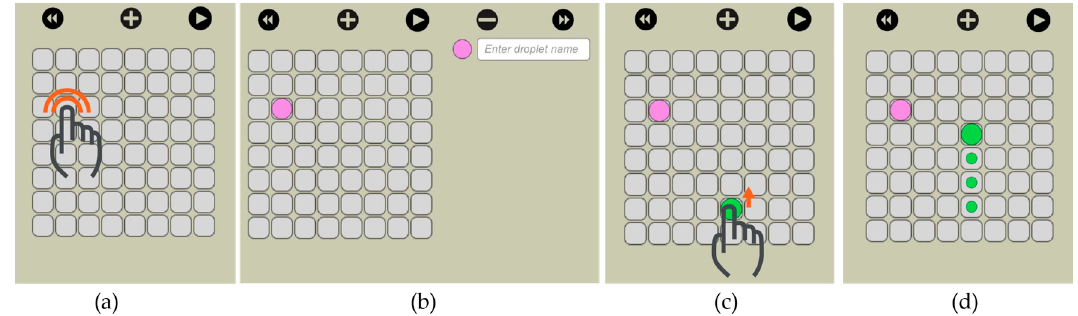
Figure 11. Through the software the user interacts with the droplets. ( a ) A new droplet is created by double tap on an empty electrode; ( b ) The user has the option to give a descriptive name to the droplet; ( c ) When using finger drag, the user decides on the route of the droplet that can be backtracked; ( d ) by looking at the traces.